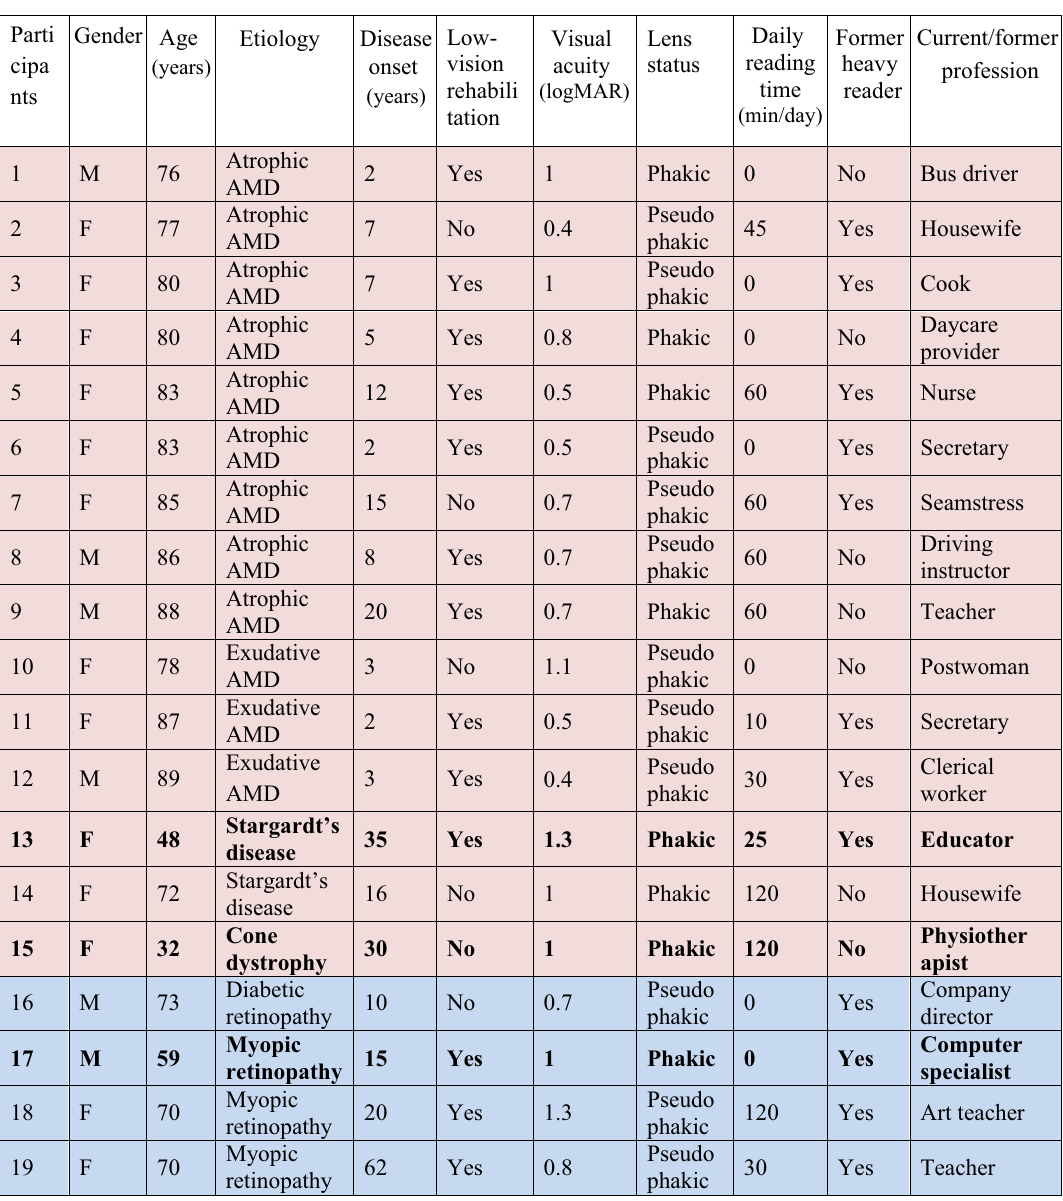
Table 1. Participants’ demographic, visual and reading characteristics. Visual acuity and lens status are given for the tested eye only. Participants with central scotoma only are highlighted in red. Participants with central scotoma and peripheral lesions are highlighted in blue. Participants who are still active workers are highlighted in bold